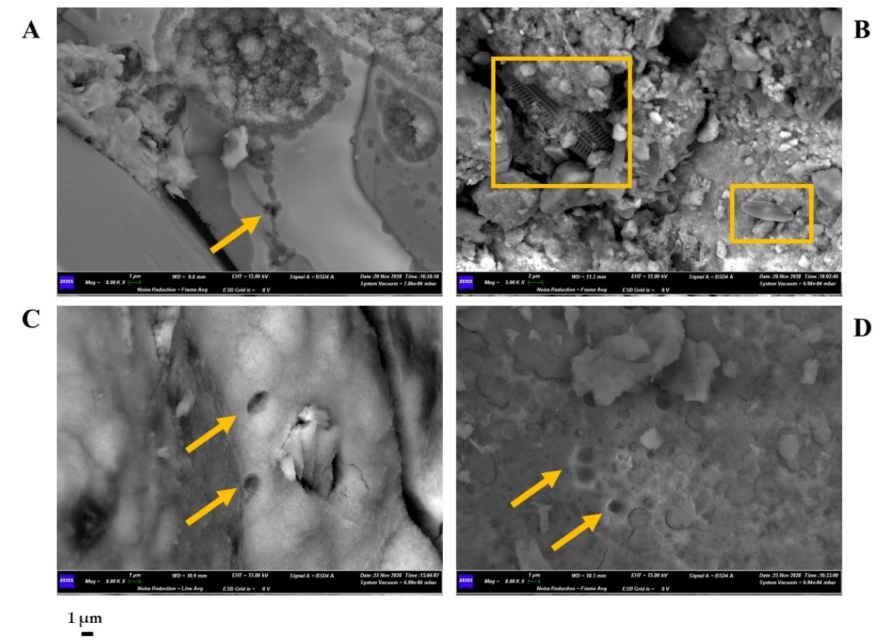
Figure 7. Scanning Electron Microscope (SEM) micrographs obtained for sample S1 ( A , B ) and S3 ( C , D ). Microbial imprints are highlighted with arrows. Squares indicate the presence of diatoms. Scale bar (1 µ